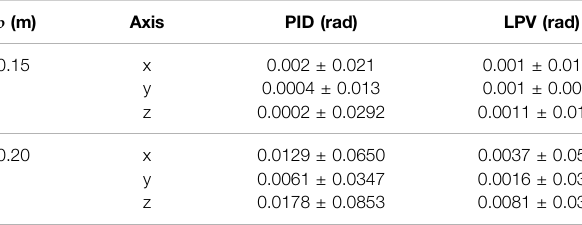
TABLE 1 | Mean and standard deviation of the orientation error at different inter- magnetic